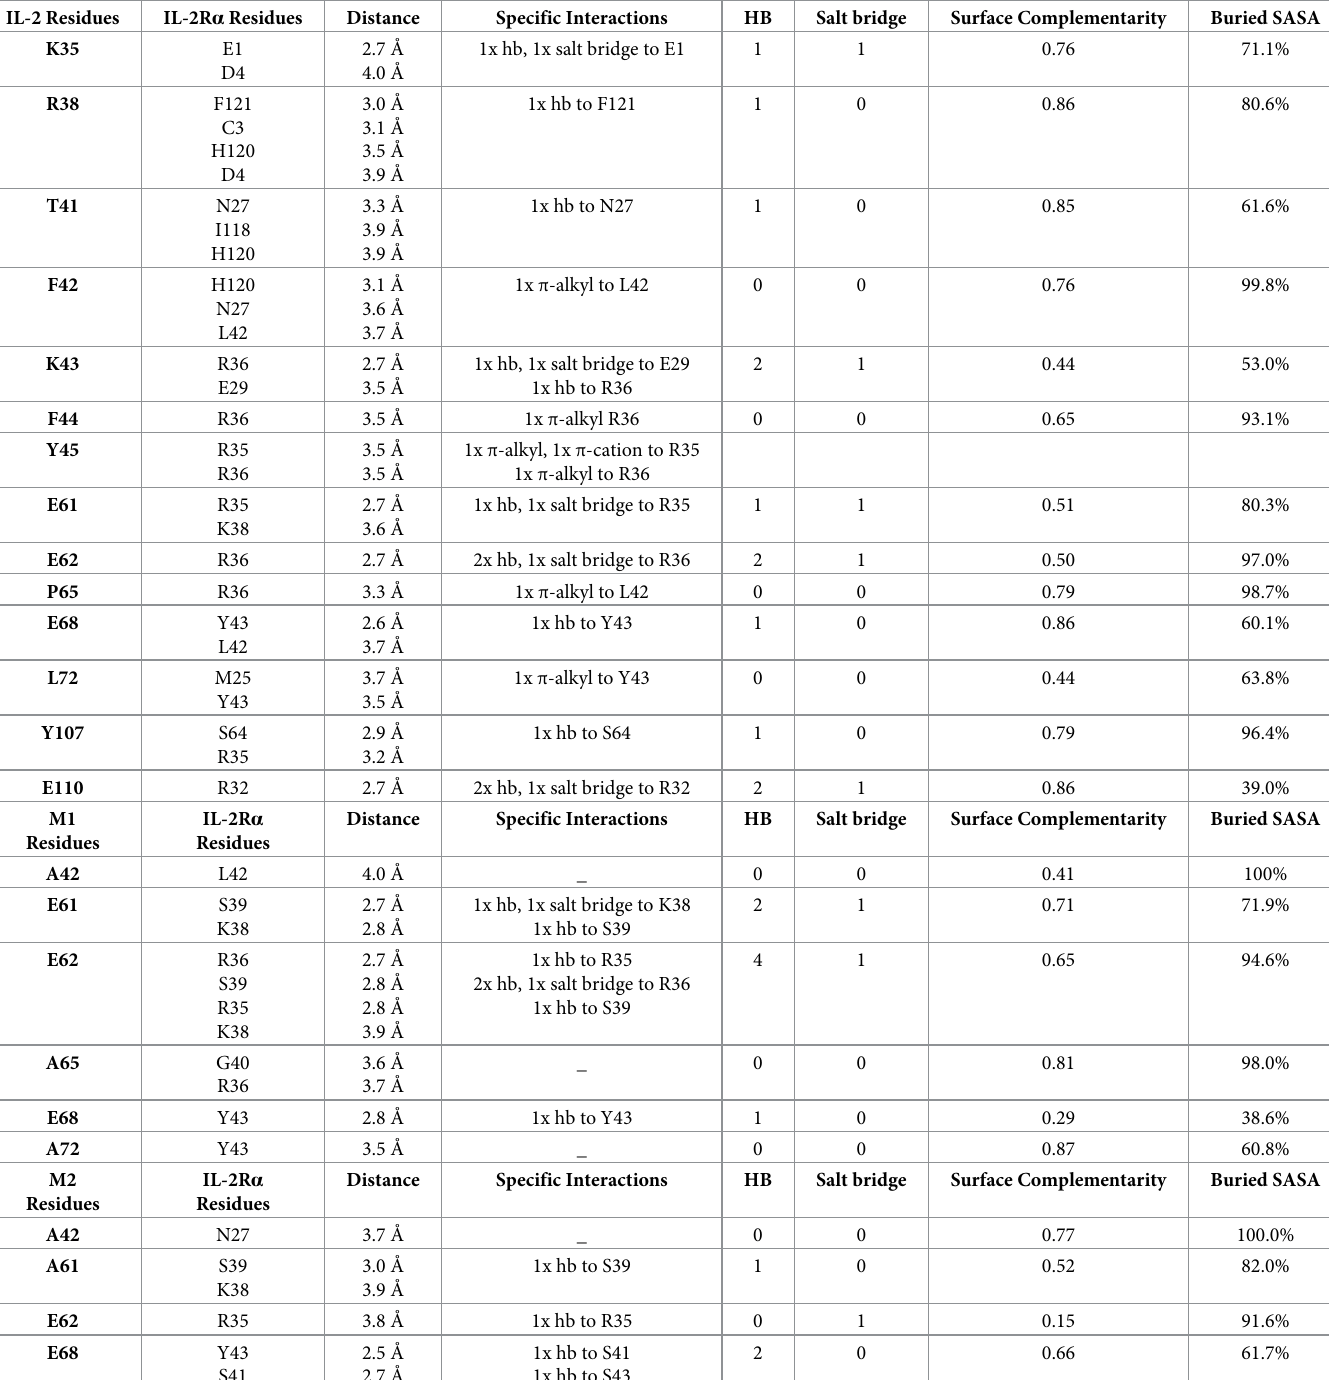
Table 2. Main interactions observed between wtIL-2, M1, and M2 mutants with IL-2R α During 100ns of MDs. IL-2